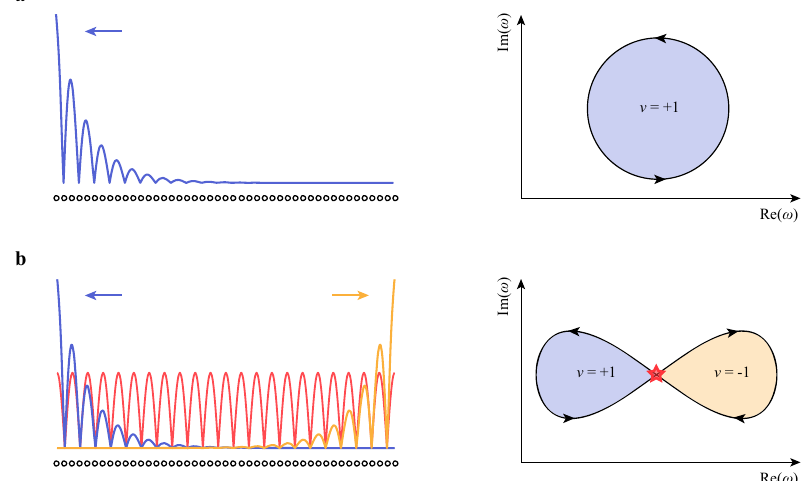
Fig. 1 Comparison of NHSE arising from different winding topologies. a In the conventional NHSE, all bulk eigenstates localize at a boundary (left panel). This corresponds to the single-loop winding of the complex energy spectrum in the complex plane (right panel). The winding direction is characterized by the winding number ( v = + 1 in the illustration) that determines which boundary (the left boundary in the illustration) the bulk eigenstates should localize toward. b A twisted winding topology consists of two oppositely oriented loops in contact (right panel). The corresponding NHSE exhibits bipolar localization, where bulk eigenstates localize towards two directions (left panel). The contact point (denoted by a red star in the right panel) corresponds to a Bloch-wave-like extended state (red line illustrated in the left panel). In the left panels, the dots at the bottom present the lattice; the arrows indicate the directions that the eigenstates shall collapse